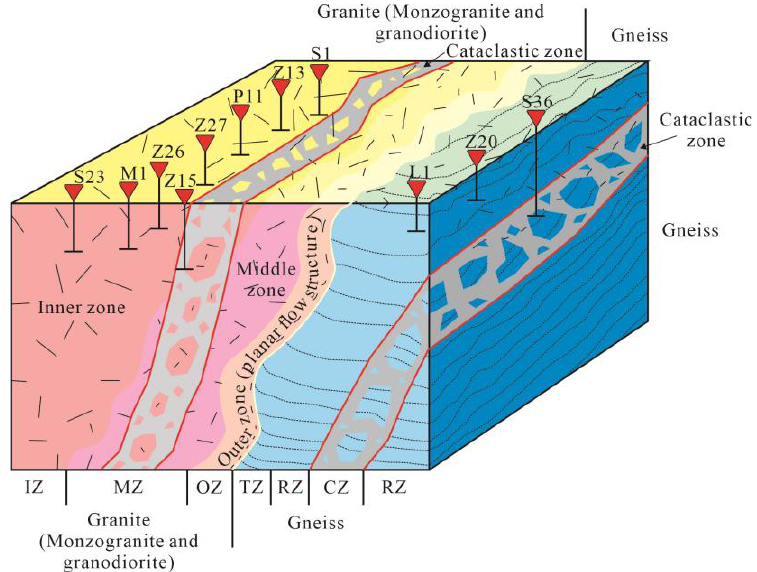
Figure 3. Model of the lithological associations revealed by boreholes in the LS depression, ECSB. Note: IZ, Inner zone; MZ, middle zone; OZ, outer zone; TZ, tilted zone; RZ, regular zone; and CZ, cataclastic zone.